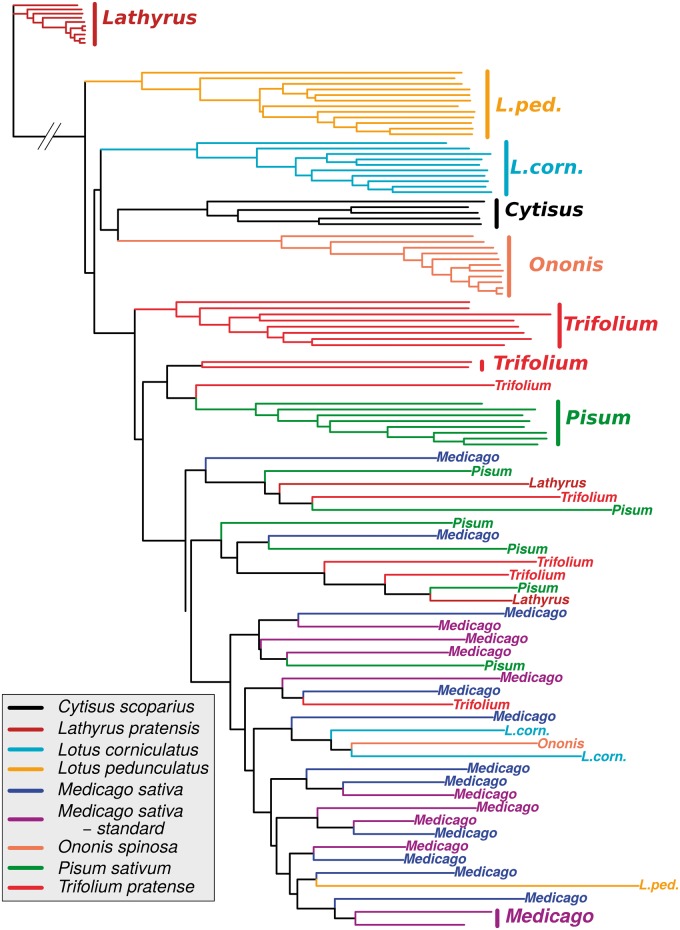
Neighbor-joining tree based on CNV information. The distance matrix was obtained by conversion of the RF proximity matrix computed from the 114 independent subtargets most informative to discriminate races. Clones from both the training and the test set are represented on the tree (see Materials and Methods). The branch leading to the Lathyrus outgroup has been shortened by a factor 4.6.